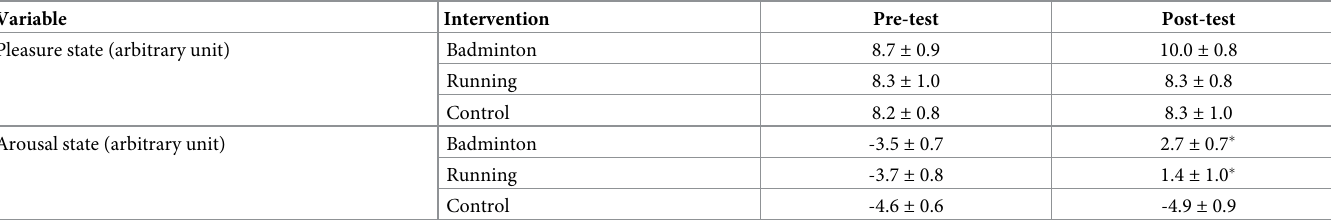
Table 3. Psychological states in each intervention (mean ±